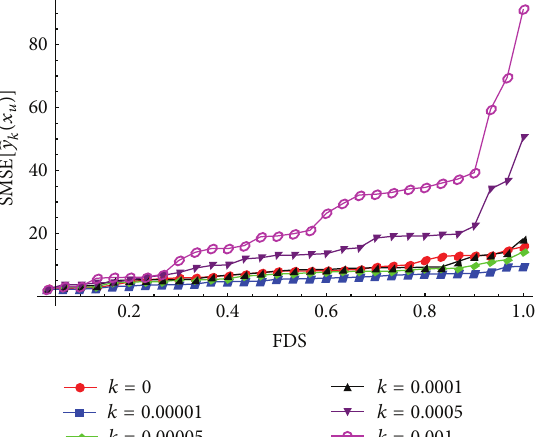
Figure 2: The FDS plots for different 𝑘 values according to the randomly generated mixture, where